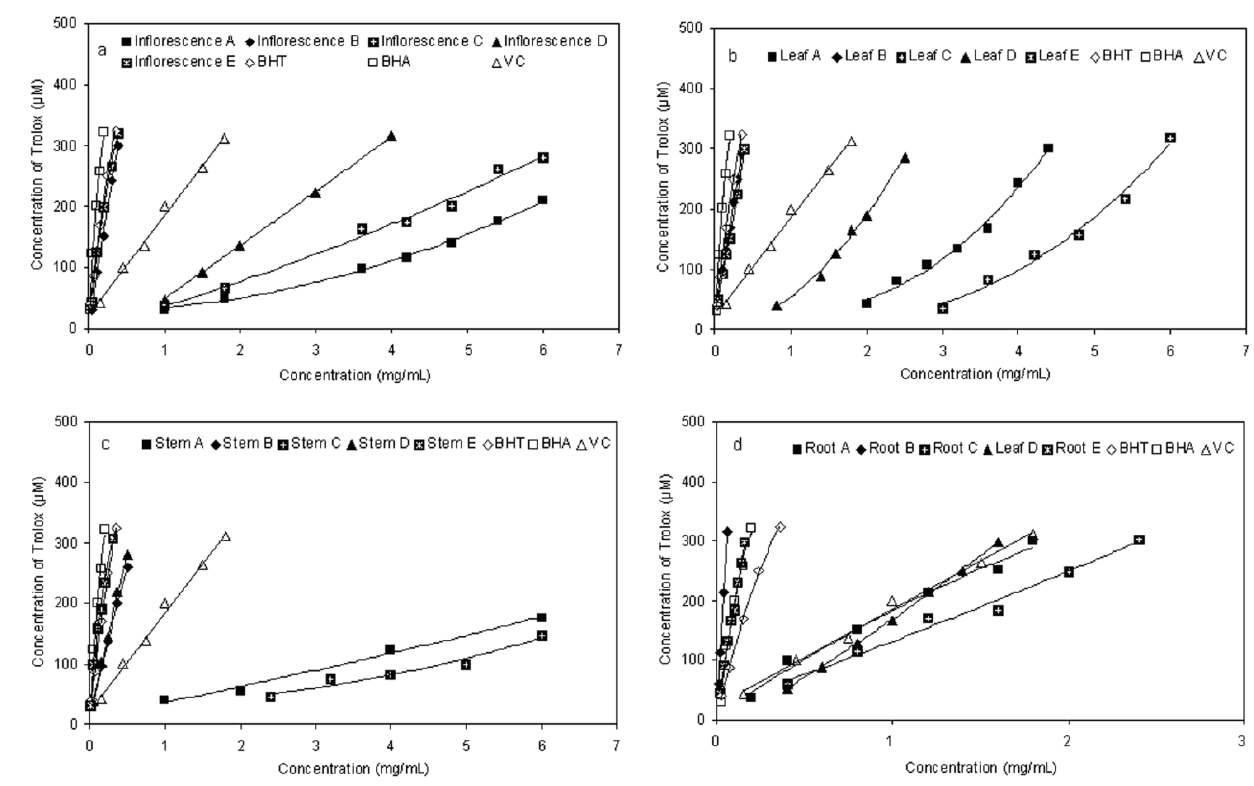
Figure 5. Ferric-reducing antioxidant power (FRAP) assay for fractions of different parts of E. ciliata